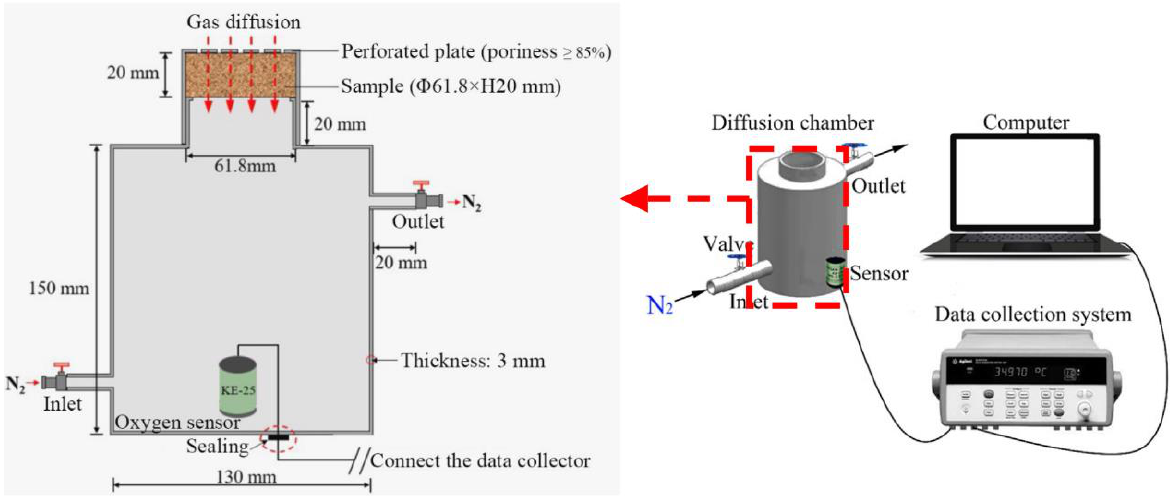
Figure 2. The 3D printing gas diffusion chamber.